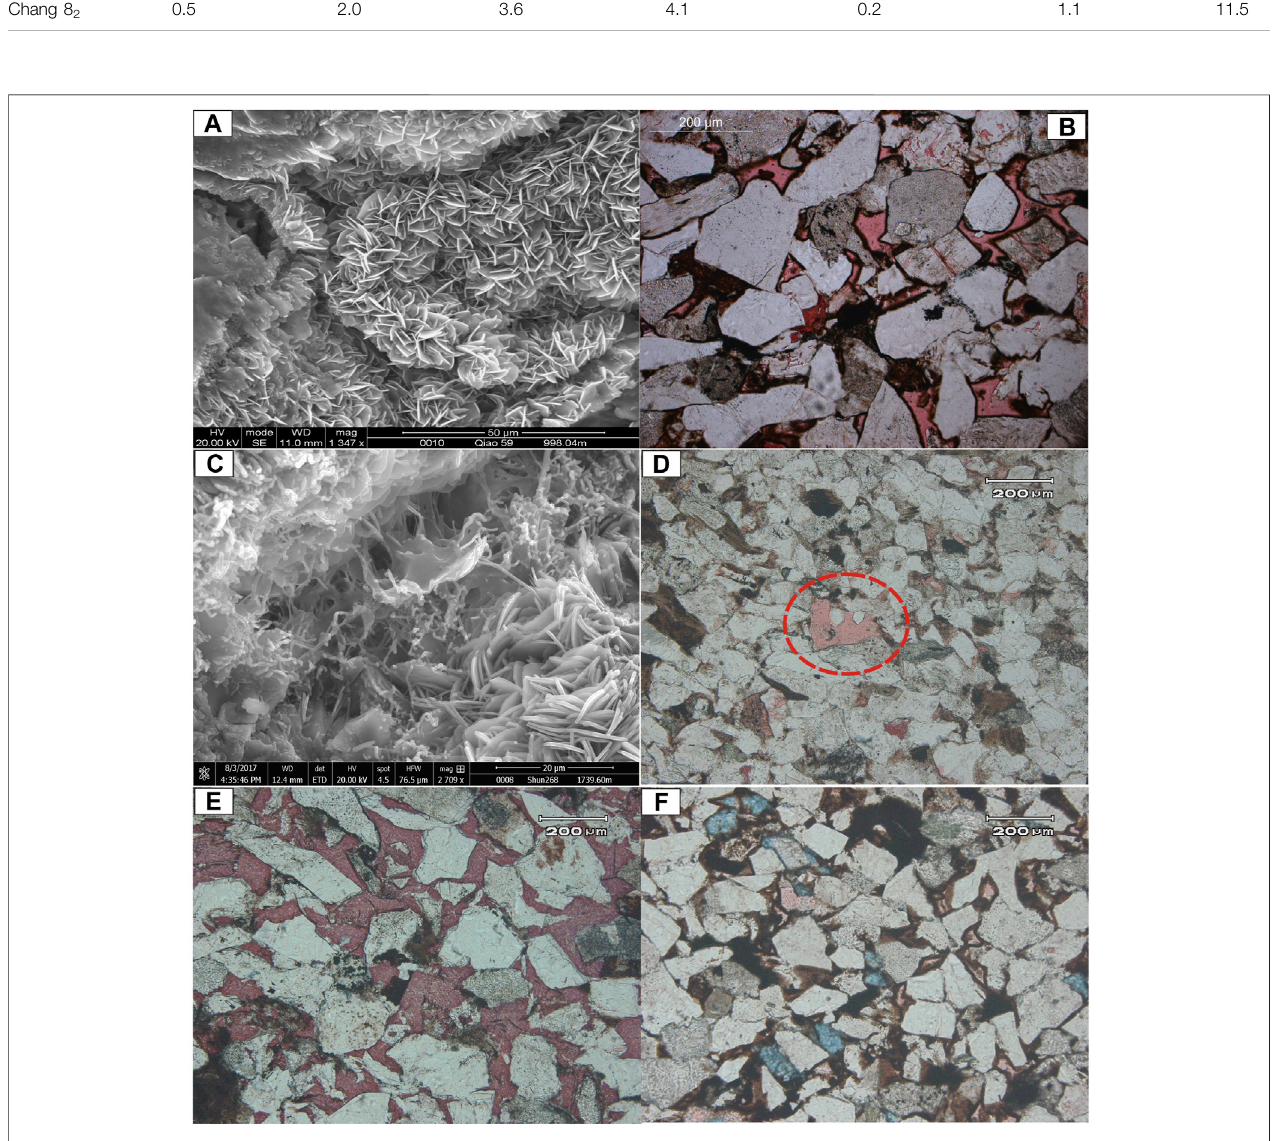
FIGURE 3 | Thin section and SEM images of Chang 8 interstitial fi lling in Wuqi – Zhijing – Ansai area. (A) Chlorite thin fi lm on particle surface, Q59, 998.04 m; (B) chlorite thin fi lm on the edge of the particles and adsorbed organic matter, X248, 2,063.40 m; (C) fi lamentous illite fi lls the pores, S268, 1,739.60 m; (D) authigenic quartz, Y55, 2,036.50 m; (E) ferrocalcite fi lls the pores and metasomates the particles, X311, 2,063.00 m; (F) ferrodolomite fi lls the pores, X416, 1,954.10 m.